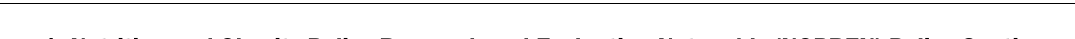
Figure 1. Nutrition and Obesity Policy Research and Evaluation Network’s (NOPREN) Policy